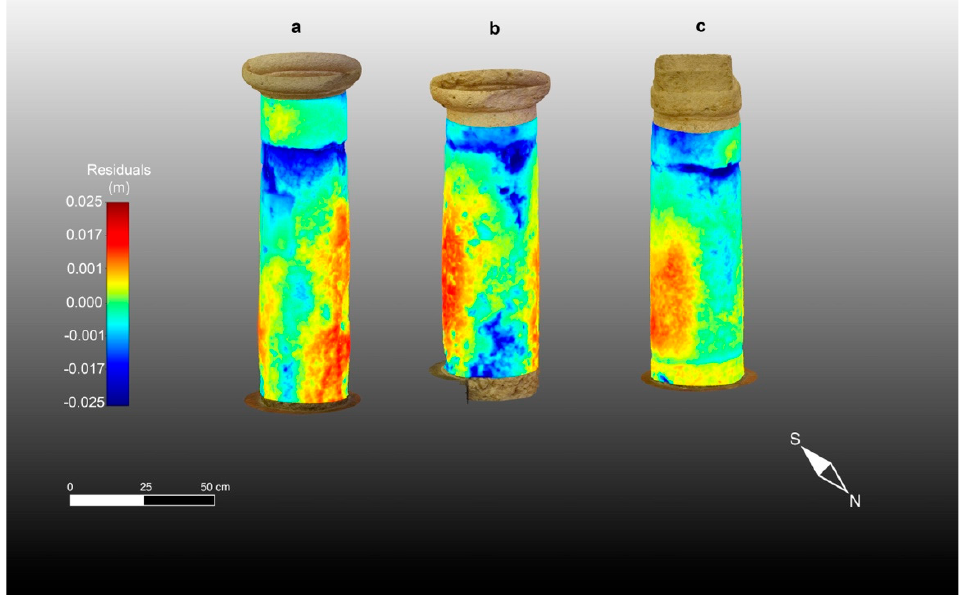
Figure 12. Geometrical Anomalies of the three studied columns representing the residuals compared with a fitted cylindric geometry adopted as reference superimposed onto the photogrammetric high-resolution 3D models: ( a ) column 1; ( b ) column 2; ( c ) column 3.